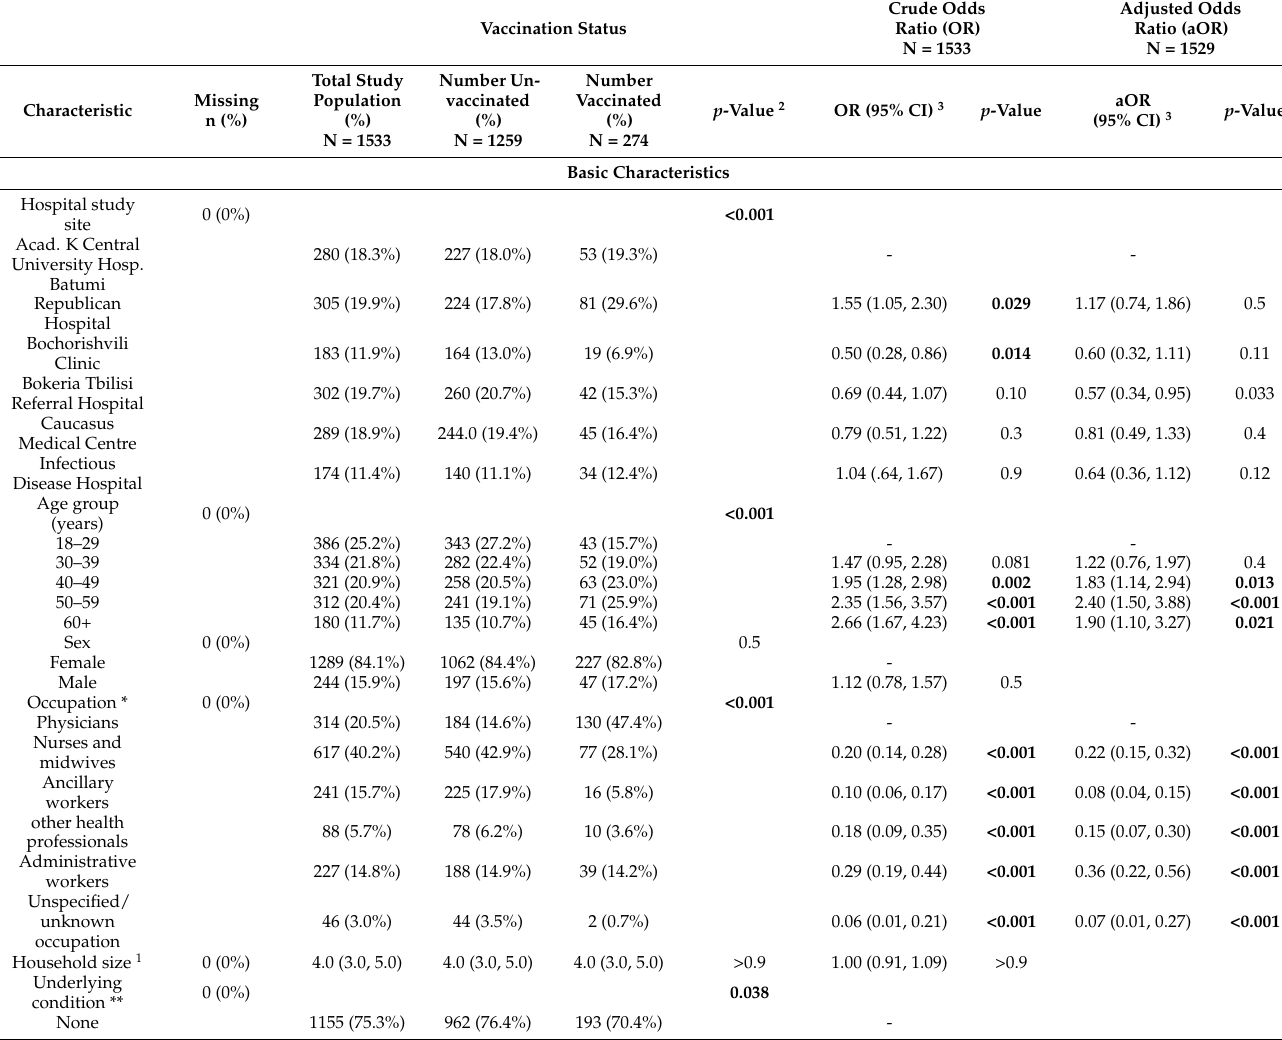
Table 1. Characteristics of health workers and factors associated with early COVID-19 uptake in the univariable and multivariable analysis, Georgia, March–July 2021. Vaccination Status